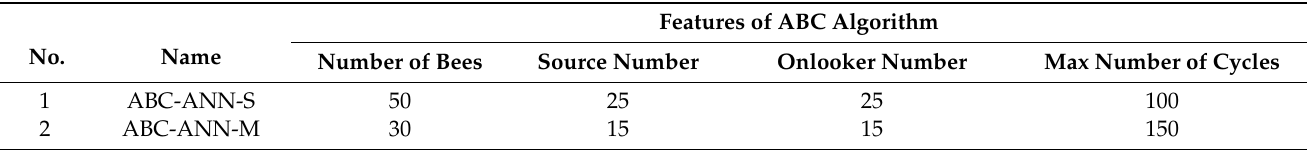
Table 5. Features of ABC algorithm in the proposed ANN model.